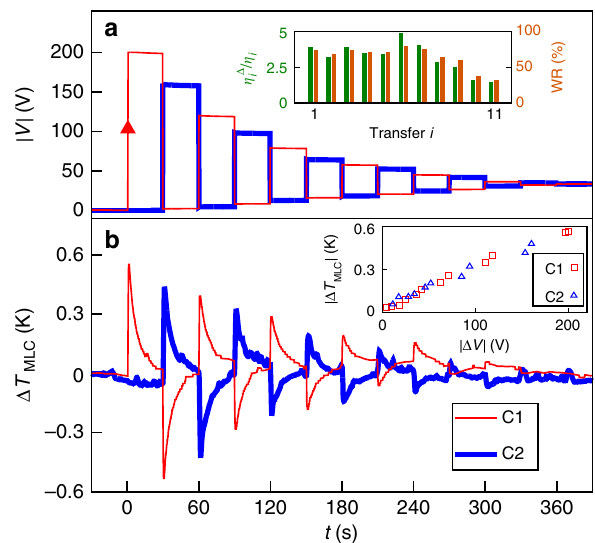
Fig. 4 Demonstration of energy recovery. a Voltage magnitude | V | across C1 (thin red line) and C2 (thick blue line) after charging C1 at time t = 0 (red arrow) and then transferring charge between C1 and C2 every 30 s Þ and (transfer i took place at t = 30 i s). Inset: η Δ i = η i ¼ W i = ð W i (cid:2) W i þ 1 = W W WR = 1 − η i = η Δ i ¼ W i þ i , where work i denotes the work done in 1 transfer i by the MLC that discharges. b The corresponding changes of EC temperature Δ T MLC for C1 (thin red line) and C2 (thick blue line). Inset: for C1 and C2, we plot the sharp jumps of | Δ T MLC | in b vs. the corresponding jumps of | Δ V | in